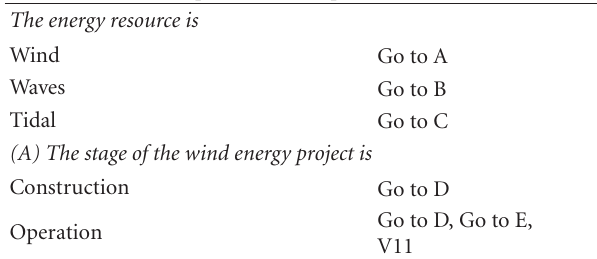
Table 11: Component decision tree for impacts on avian species. The key is followed to obtain a recommended suite of monitoring